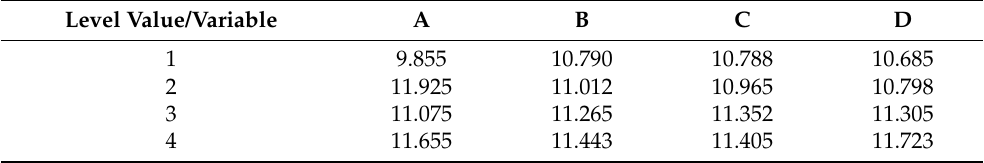
Table 8. Average no-load back EMF for each variable at the horizontal factor.